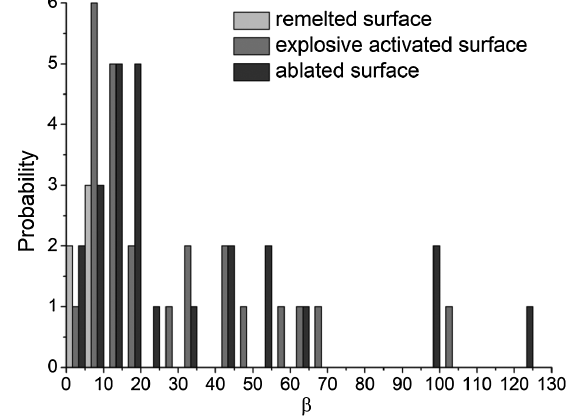
FIG. 7. Distribution of the field enhancement factors, β , derived E curves for boiled craters, slightly melted regions, from the I FE and after the explosive breakdowns.